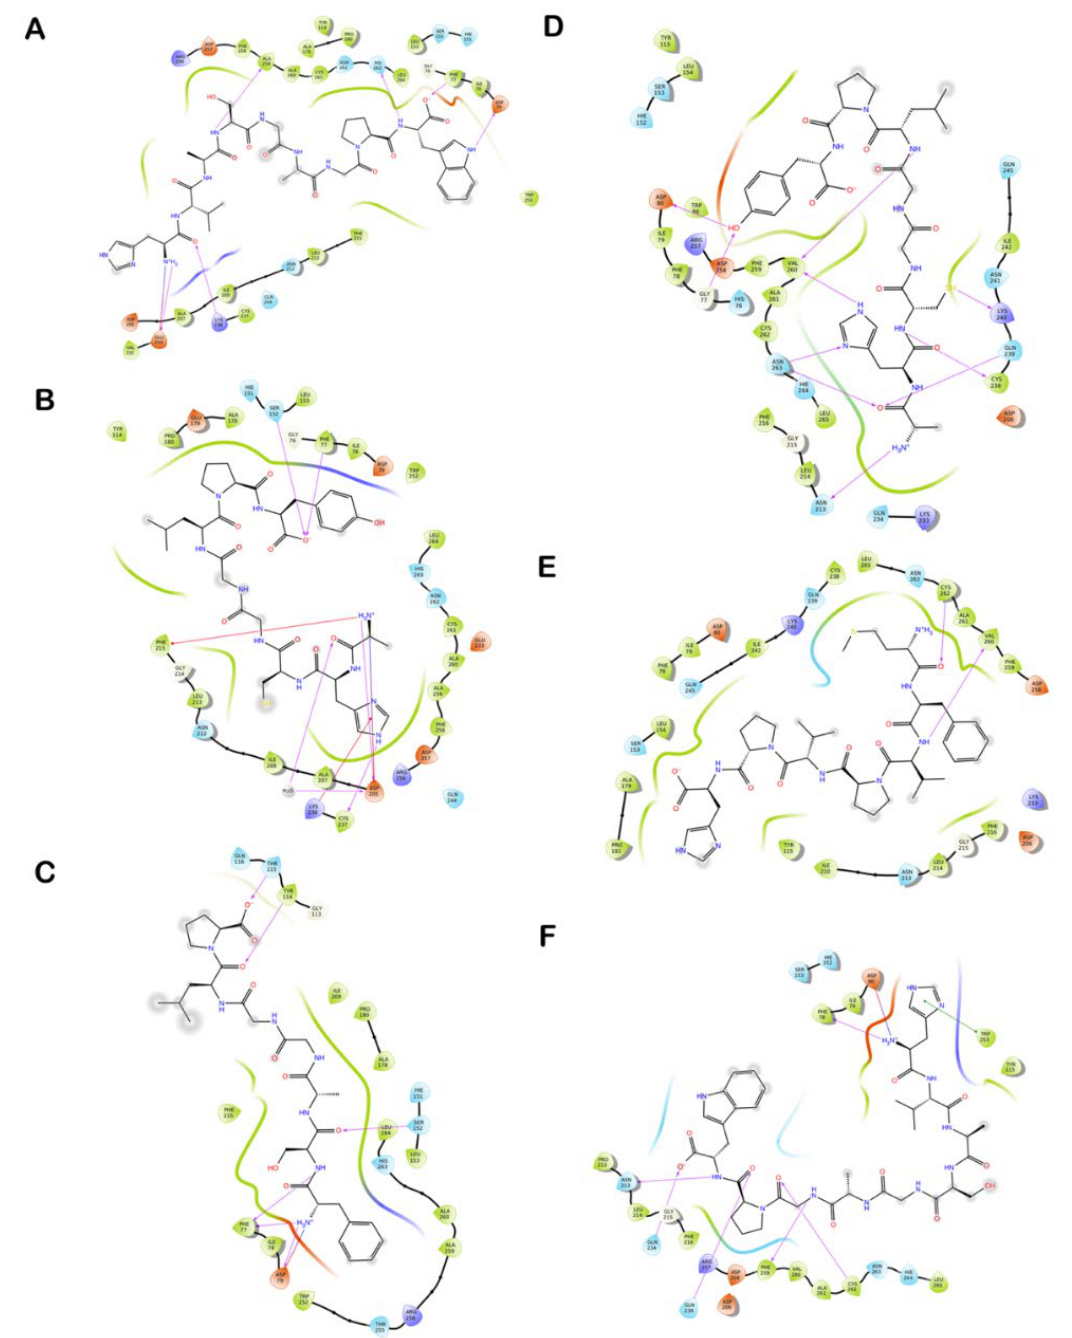
Figure 4. Ligand interaction diagram of inhibitory peptides with the residues of the enzyme PL. The interactions of peptides ( A ) HVASGAGPW, ( B ) AHCGGLPY, and ( C ) FSAGGLP in the active site of human PL. Interactions of peptides ( D ) AHCGGLPY, ( E ) MFVPVPH and ( F ) HVASGAGPW in the active site of porcine PL. Purple circles represent positively charged amino acids, red circles represent negatively charged amino acids, green circles represent hydrophobic amino acids, and light blue circles represent polar amino acids. Purple dashed arrows represent hydrogen bonds involving the amino acid side chain and regular purple arrows represent hydrogen bonds involving the amino acid backbone. π - π interactions are represented with green lines.